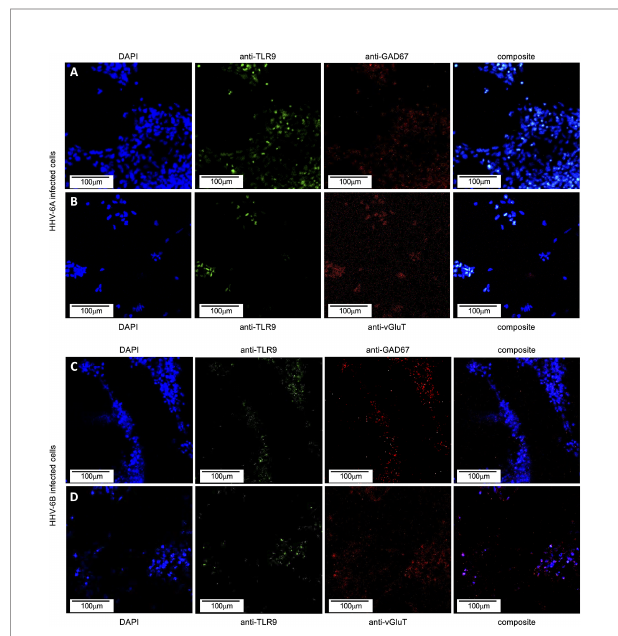
and HHV-6B infected dHNSCs express TLR9. (A) DAPI stained cells ( blue, left ) emitting GAD67-positive immuno fl uorescence signals ( red, mid-right ) also show signal for anti-TLR9 fl uoroprobes ( green, mid-left ) during HHV-6A infection. (B) HHV-6A infected VGluT-positive neurons ( red, mid-right ) stained with DAPI ( blue, left ) also show coincident TLR9 immuno fl uorescence ( green, mid-right ). (C) DAPI stained cells ( blue, left ) emitting GAD67-positive immuno fl uorescence signals ( red, mid-right ) also show signal for anti-TLR9 fl uoroprobes ( green, mid-left ) during HHV-6B infection. (D) HHV-6B infected VGluT-positive cells ( red, mid-right ) stained with DAPI ( blue, left ) also show coincident TLR9 fl uorescence ( green, mid-right ). [Infections in A-D were performed seven days post-differentiation day (PDD7). [Scale bar = 100 micron].